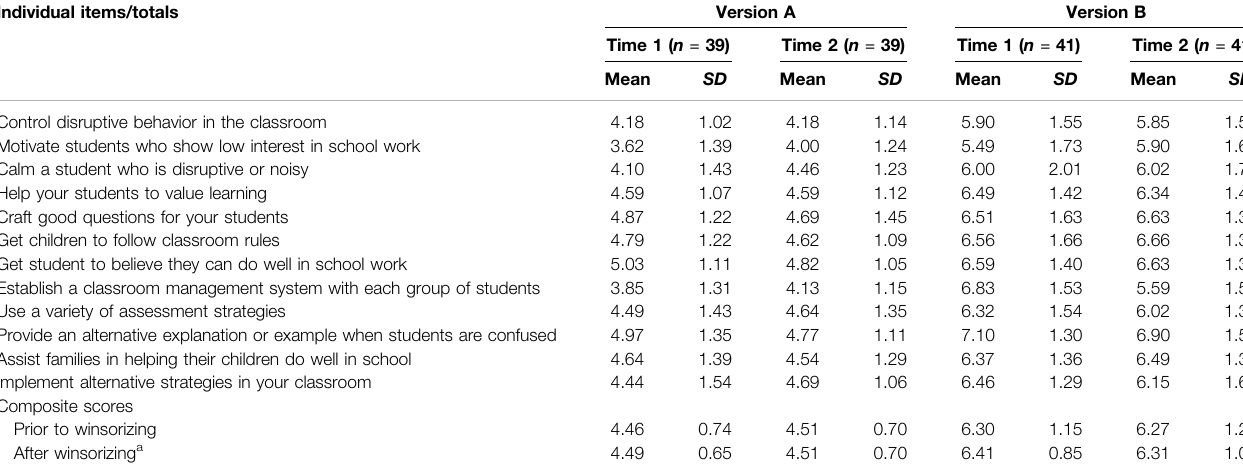
TABLE 1 | Means and standard deviations of individual items and composite scores.